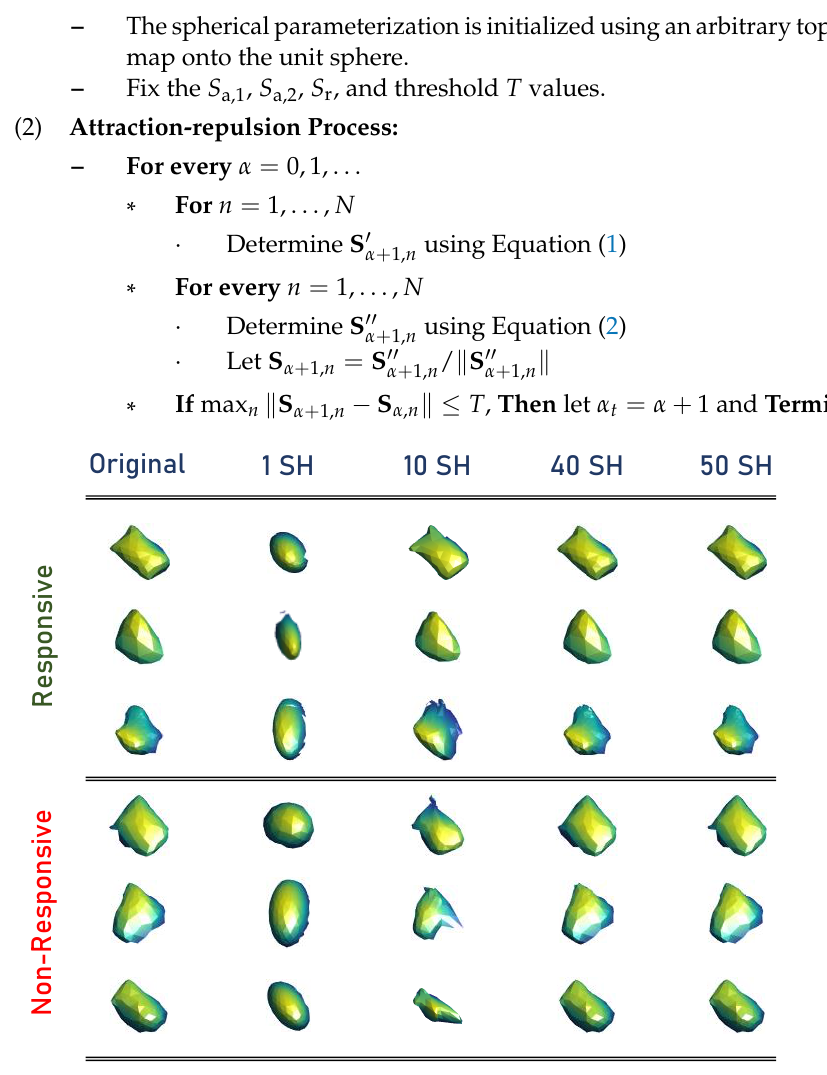
Figure 3. Samples from the constructed SHs. Sphericity is a measure of the tumor region’s roundness in relation to a sphere. It is an arbitrary measurement that is not affected by scale or direction. This measure ranges from 0 to 1 with a 0-value indicating the roughest shape and a 1-value referring to a smooth sphere. It is worth mentioning that compared with other solids, a sphere has the least surface area for a given volume. It is calculated using Equation (5), where A and V denote the surface area and volume of the tumor.